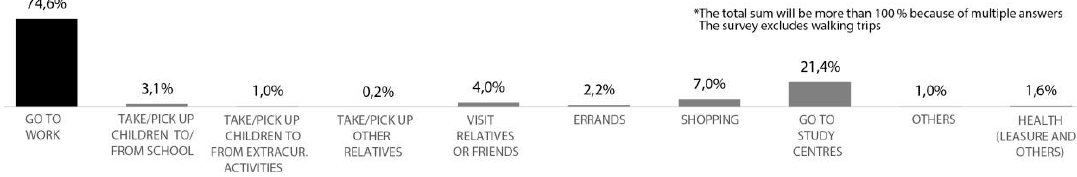
Figure 18. Trip purposes in Lima. Source: Reference [69]. Translation by authors, 2018.